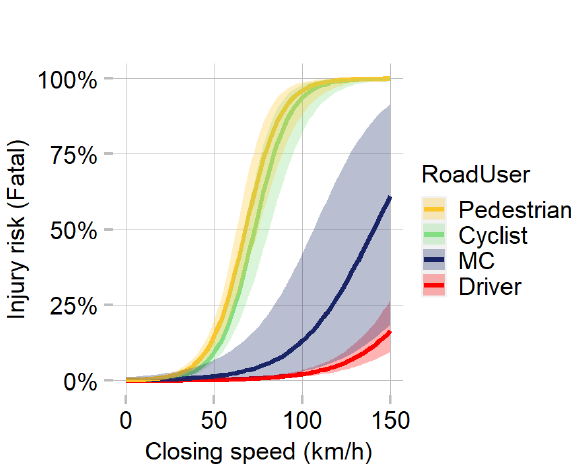
Figure 7. Fatal injury risk curves with confidence levels, for different road users at 65 years of